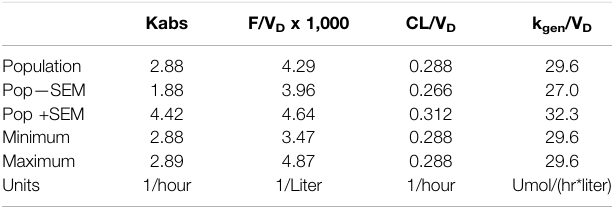
TABLE 5 | Parameters from population fi t using SimBiology ® nlme fi t with proportional error model. Kabs